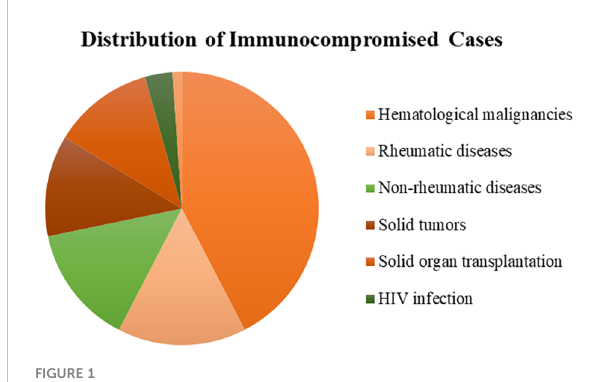
FIGURE 1 The distribution of immunocompromised patients. Most had hematological malignancies (42.3%), followed by rheumatic diseases (15.2%), non-rheumatic diseases (14.1%), solid tumors (12.0%), solid organ transplantation (12.0%), HIV infection (3.3%), and hematopoietic stem cell transplantation (1.1%). HIV, human immunode fi ciency